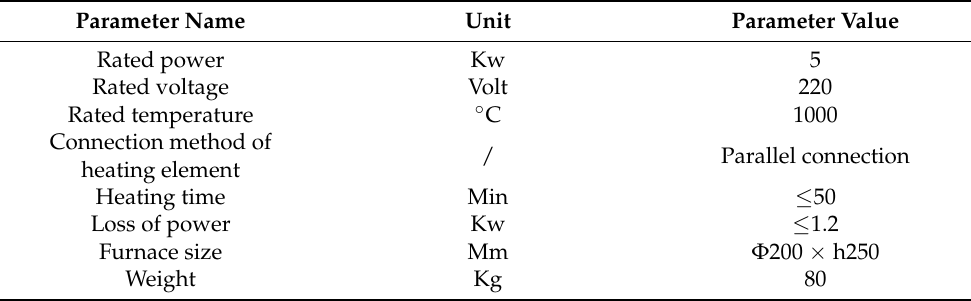
Table 1. Technical parameters of a resistance furnace (CHOY SG2-5-10).